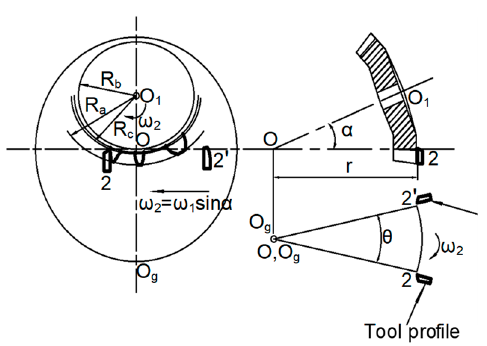
Figure 1. Concept of straight bevel gear planning.